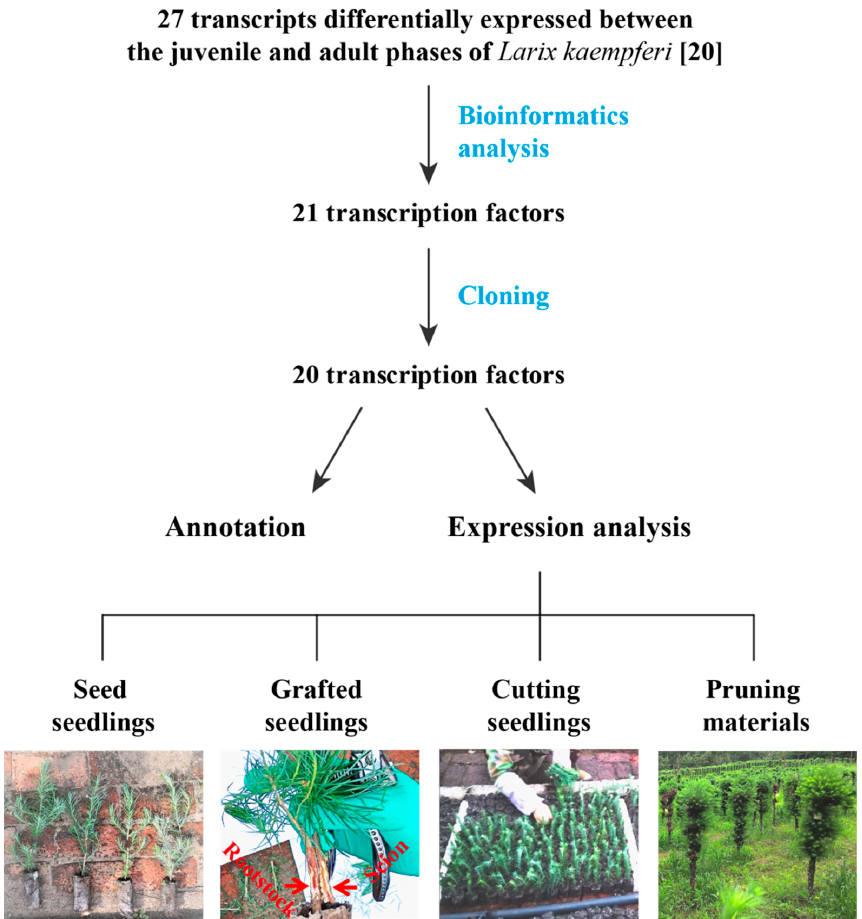
Figure 1. Analytical flowchart. Twenty-seven transcripts di ff erentially expressed between the juvenile vegetative (1- and 2-year-old) and adult reproductive (25- and 50-year-old) phases of Larix kaempferi , identified in a previous study [20] were analyzed again and used to identify molecular markers and assess the e ff ects of cutting, grafting, and pruning on gene